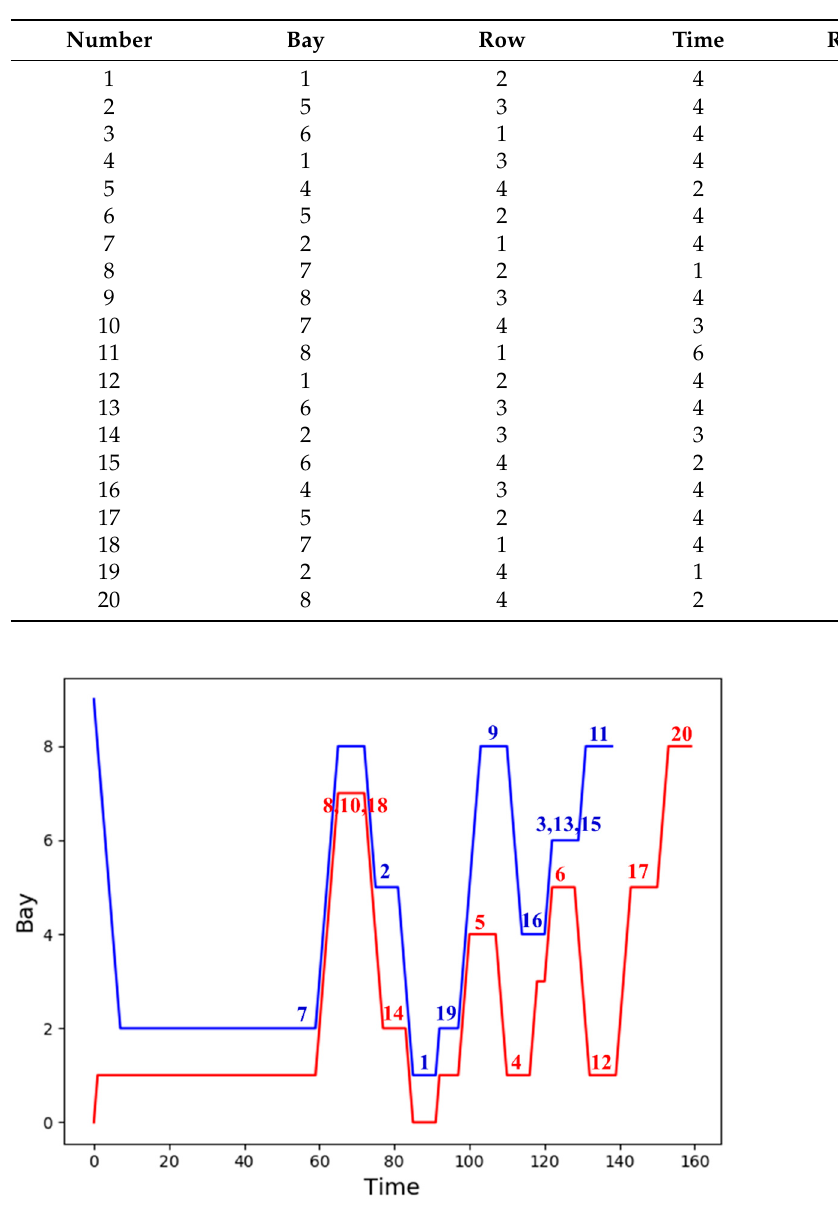
Table 6. Tasks’ release time renewal.